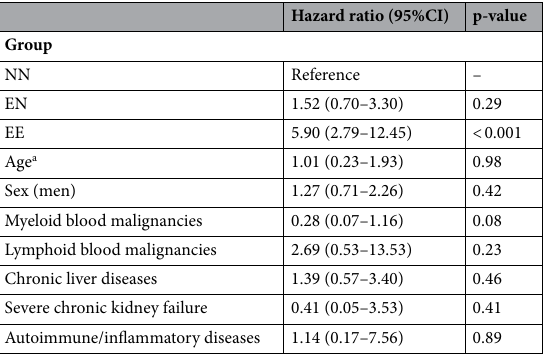
Table 2. Strength of association between incident solid cancers within 60 months and the 3 groups in an adjusted competing risk survival model with the death as a competing risk. a Age as dichotomous variable with the median age as a threshold (< or ≥ 79